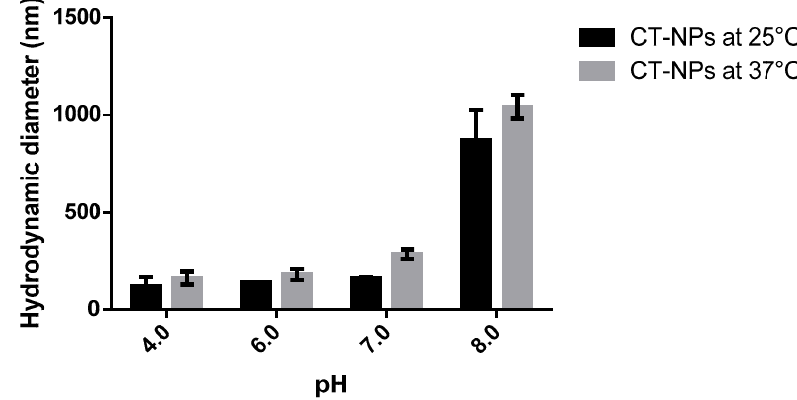
Figure 4. Stability of CT-NPs under different conditions of pH, at 25 and 37 °C.